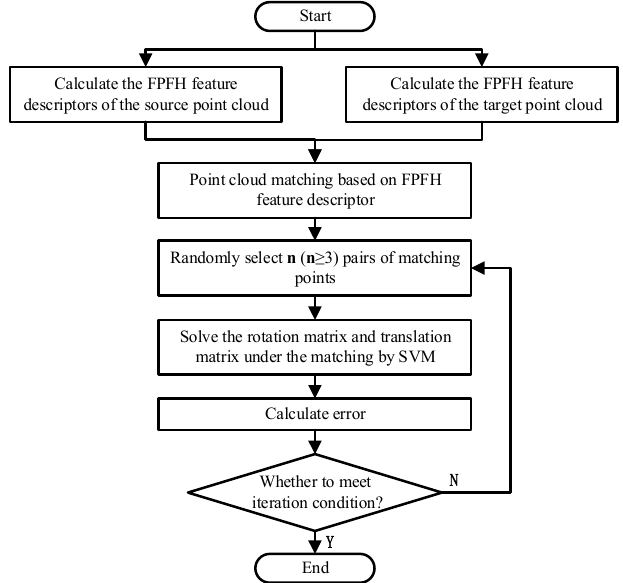
Figure 11. SAC-IA point cloud coarse registration based on FPFH features. The ICP algorithm minimizes the distance between the point on the source point cloud and the corresponding point on the target point cloud through parameter update iteration. For the points in the source point cloud P , the corresponding closest point in the target point cloud Q is calculated by Euclidean distance. According to its corresponding relationship, solve the optimal transformation matrix (transition matrix R and displacement vector T ). A new source point cloud P is obtained according to the transformation matrix, and the above process is iteratively executed until the convergence condition is satisfied. The objective function expression of the optimal transformation matrix is shown in Formula (8).